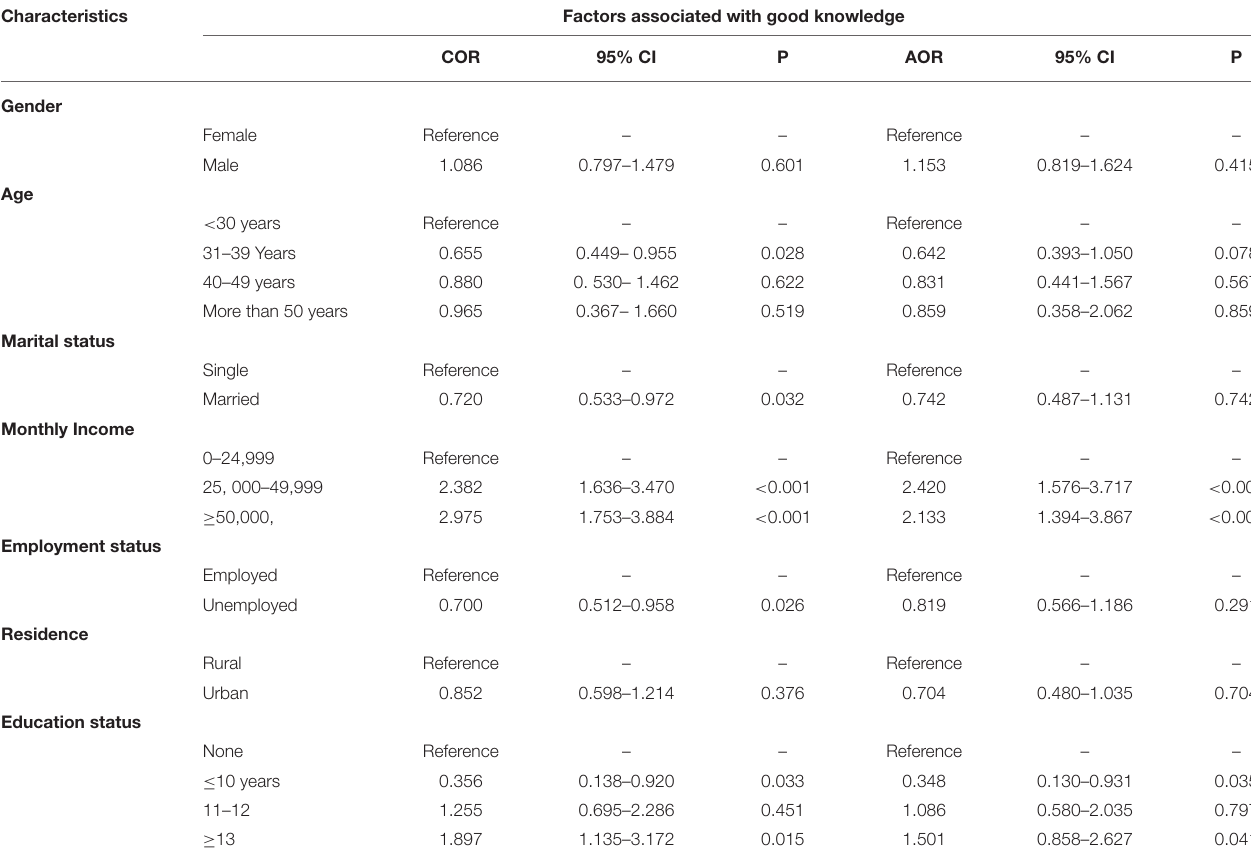
TABLE 3 | Binary logistic regression analysis for factors associated with good